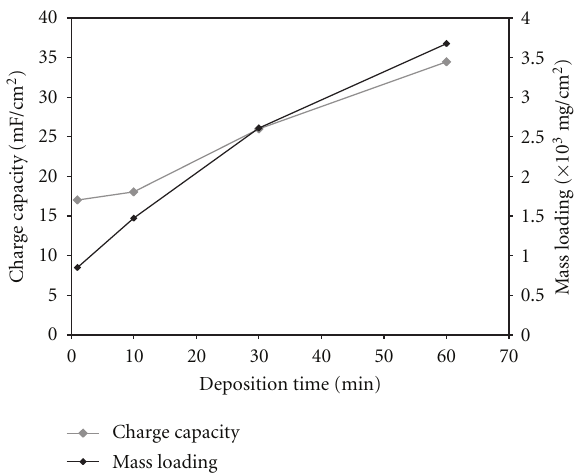
Figure 7: Charge capacity and mass loading of MnO 2 thin films deposited at various submersion durations.